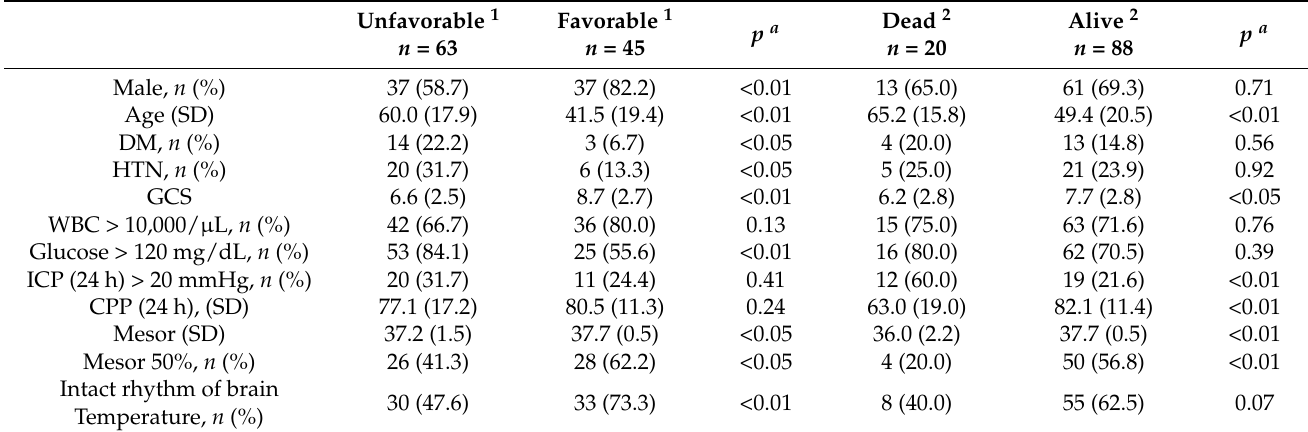
Table 2. Univariate analysis for postoperative outcomes. Unfavorable 1 Favorable 1 n = 63